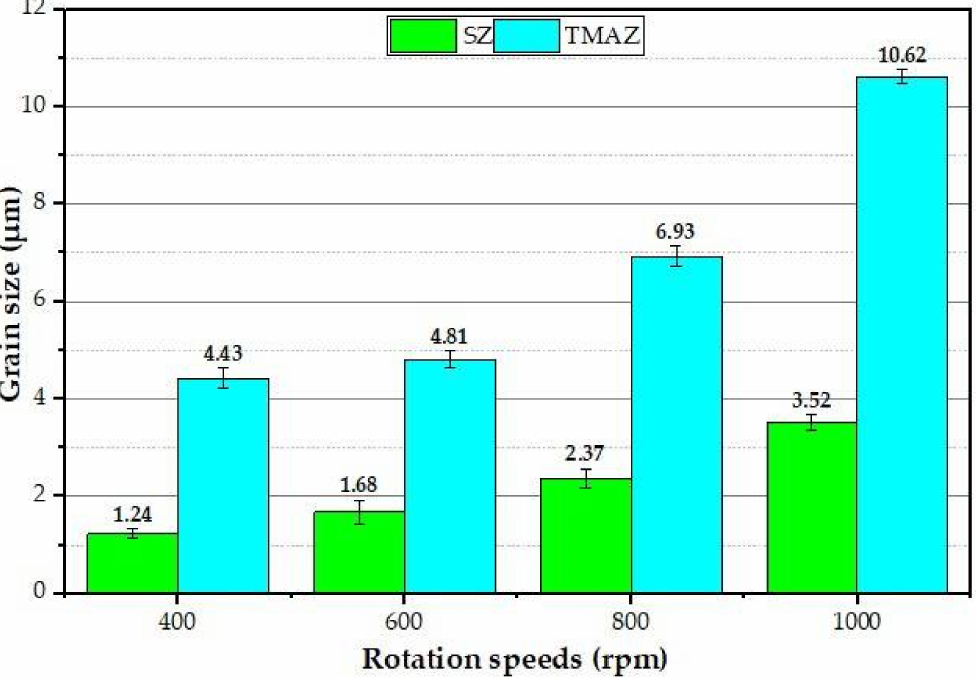
Figure 15. The mean grain size of the SZ and TMAZ of the joints spot welded at 400, 600, 800, and 1000 rpm rotation speed, and 3 s dwell